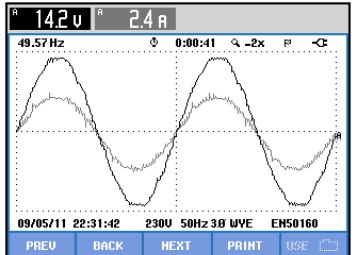
Figure 13. Grid voltage and current for inductive load in grid-connected mode.